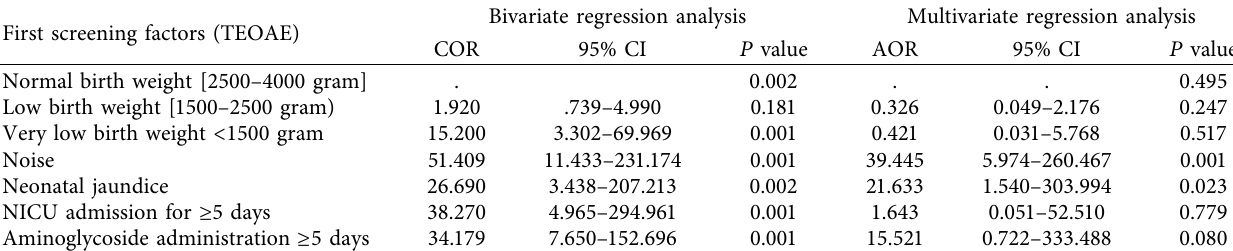
Table 4: Bivariate and multivariate regression analyses of factors associated with follow-up screening outcomes of TEOAE—7. First screening factors (TEOAE)